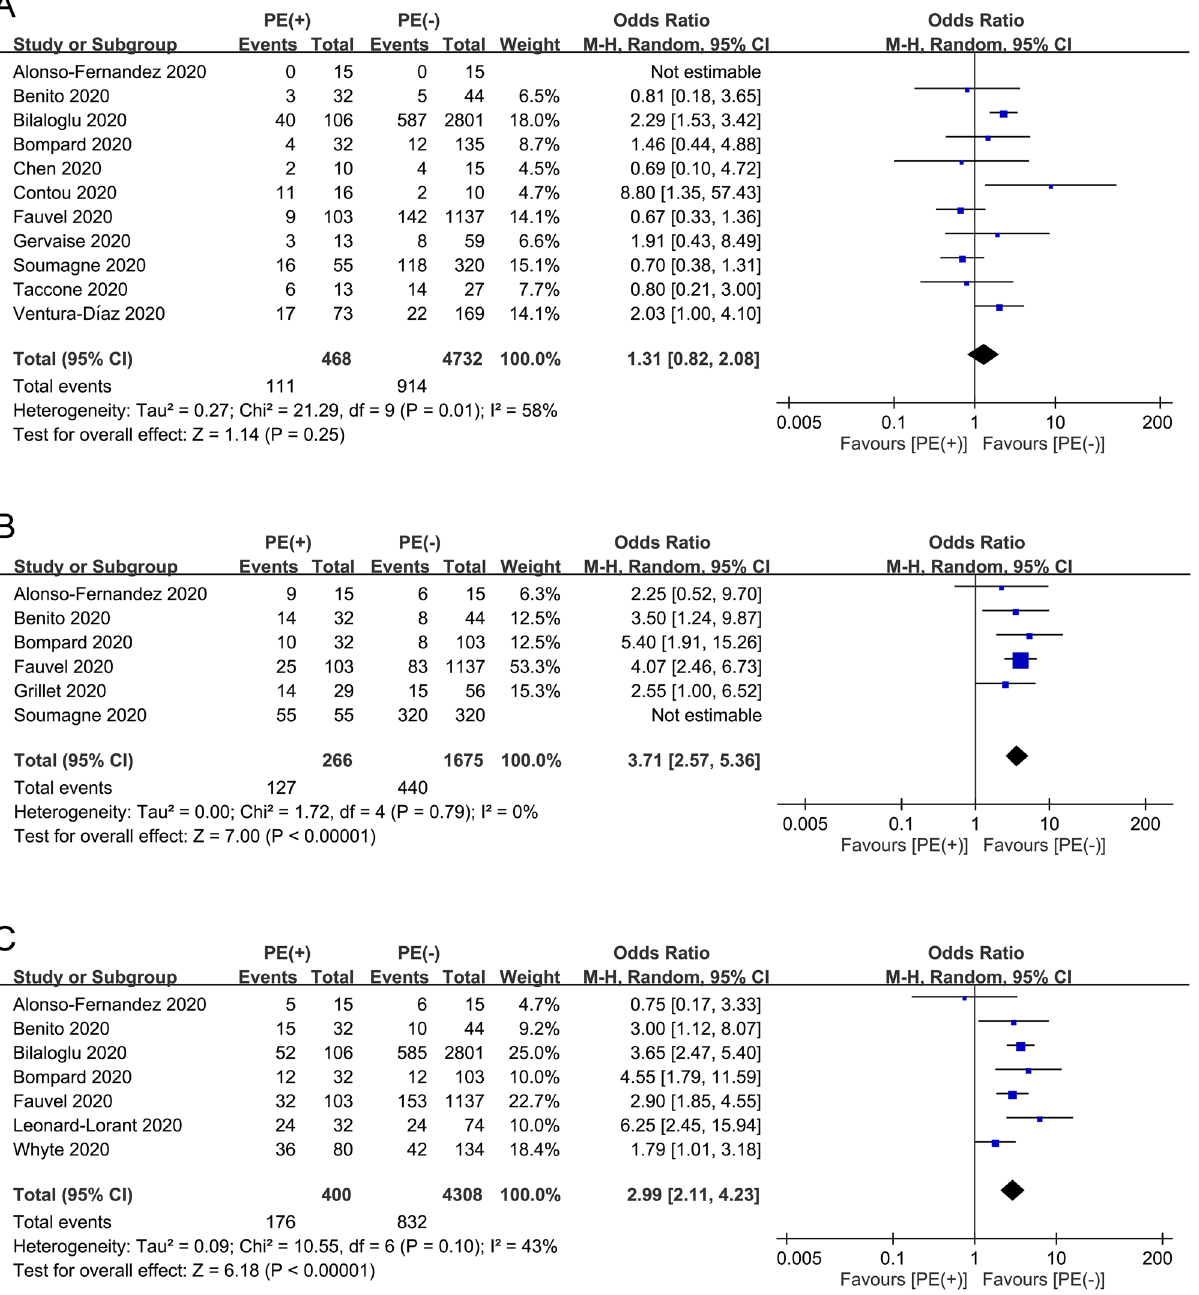
CI − 1.78 to 0.25, p = 0.14; I 2 = 28%) (Fig. 5C). The overall results of the impact of BMI on the risk of PE remained